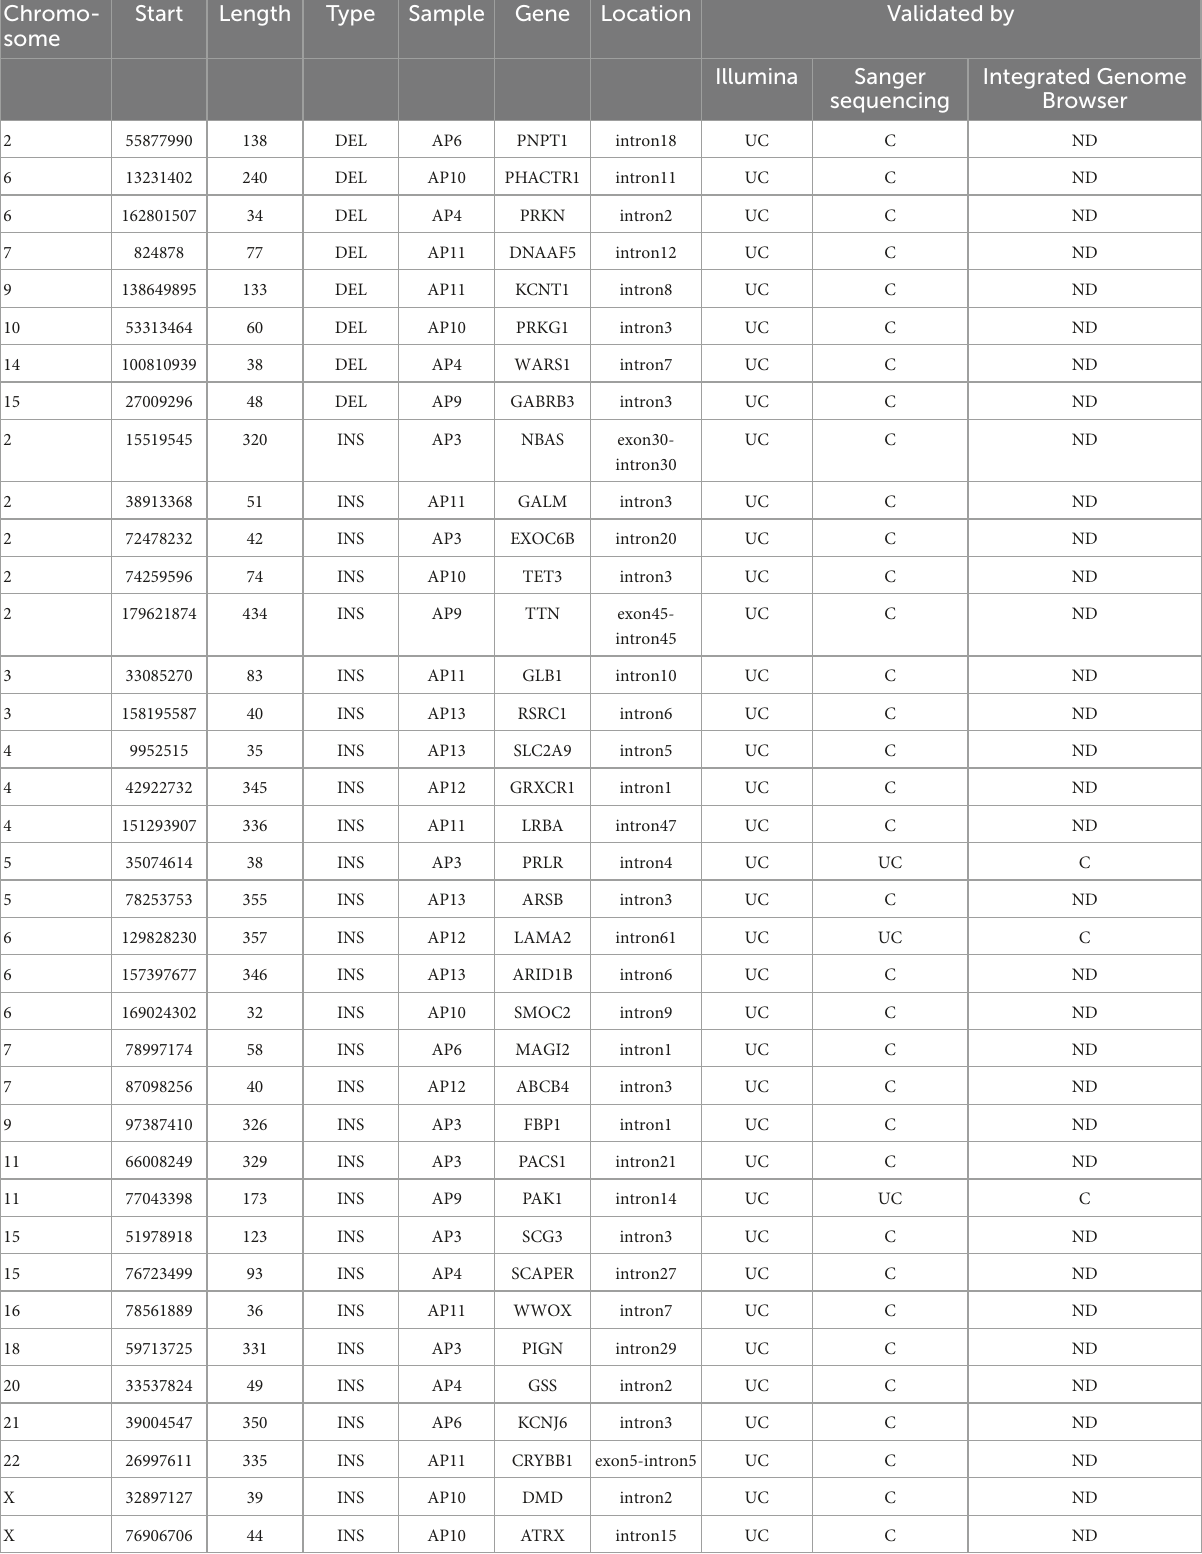
TABLE 1B The remaining 37 SVs identified by PacBio by not confirmed by Illumina found in 10 probands but not in 5 unaffected relatives. Chromo-